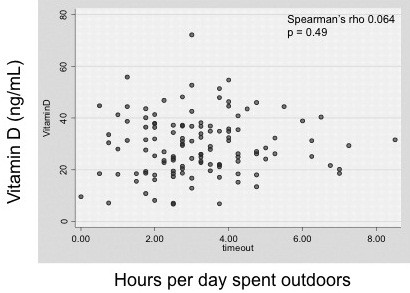
Relationship between daily time spent outdoors and serum 25-OH vitamin D levels. A scatterplot of the average hours per day spent outside vs. serum 25-OH vitamin D shows no correlation between the two. The median time spent outdoors was 3 hours/day (IQR 2–4).